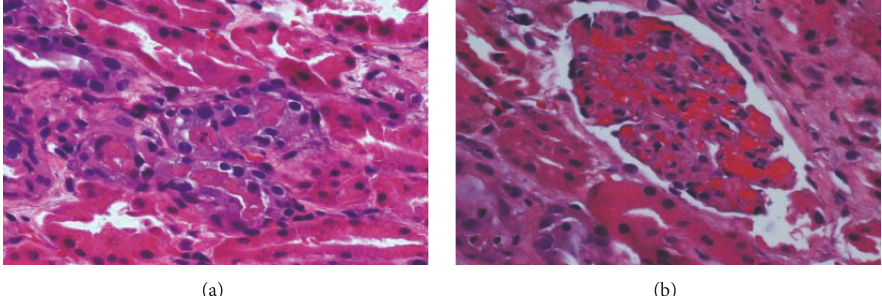
Figure 1: H&E stain. (a) Reddish tubular casts. Most tubules are preserved, mild interstitial fibrosis with tubular atrophy. (b) Glomeruli with congestion.